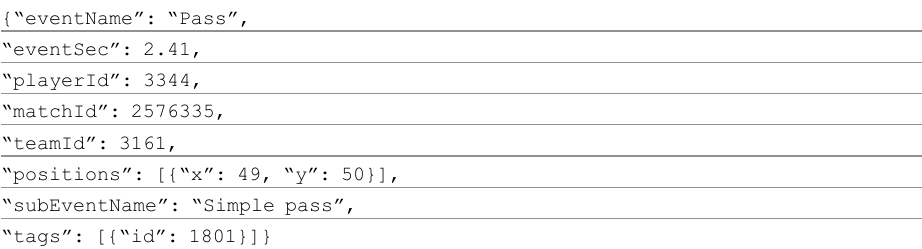
Table 1. Example of event corresponding to an accurate pass. eventName indicates the name of the event’s type: there are seven types of events (pass, foul, shot, duel, free kick, offside and touch). eventSec is the time when the event occurs (in seconds since the beginning of the current half of the match); playerId is the identifier of the player who generated the event. matchId is the match’s identifier. teamId is team’s identifier. subEventName indicates the name of the sub-event’s type. positions is the event’s origin and destination positions. Each position is a pair of coordinates (x, y) in the range [0, 100], indicating the percentage of the field from the perspective of the attacking team. tags is a list of event tags, each describing additional information about the event (e.g., accurate). A thorough description of this data format and its collection procedure can be found in